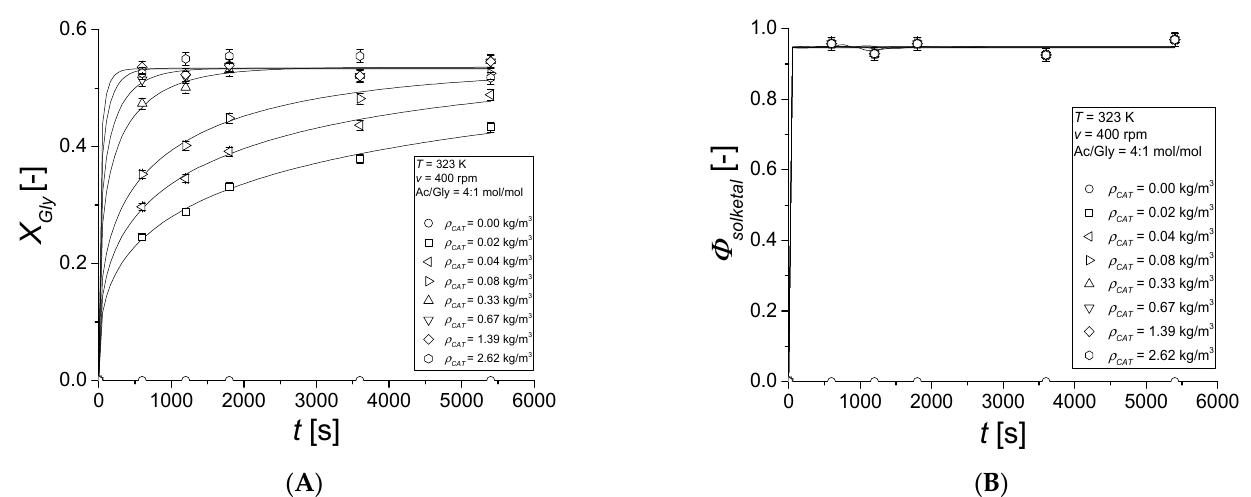
Figure 3. Catalyst load effect for catalyzed tests, fixing v = 400 rpm, Ac/Gly = 4:1 mol/mol, and T = 323 K. ( A ) Glycerol conversion. ( B ) Selectivity toward solketal.